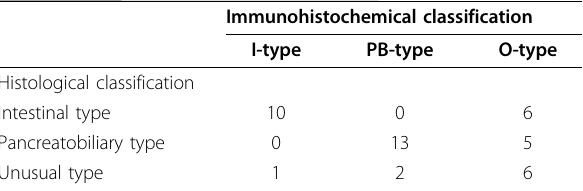
Table 3 Correlation between Immunohistochemical and Histological Classifications